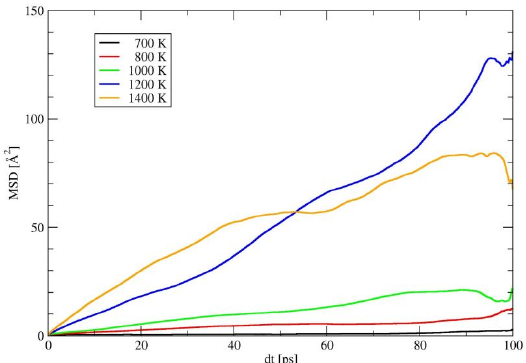
Figure 8. The MSD for Li + ions simulated by AIMD for P-doped LiSiON.